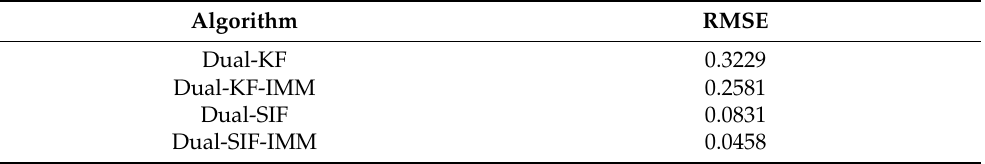
Table 6. B034 RMSE: Battery Capacity Using the Minimum at each Estimation cycle.